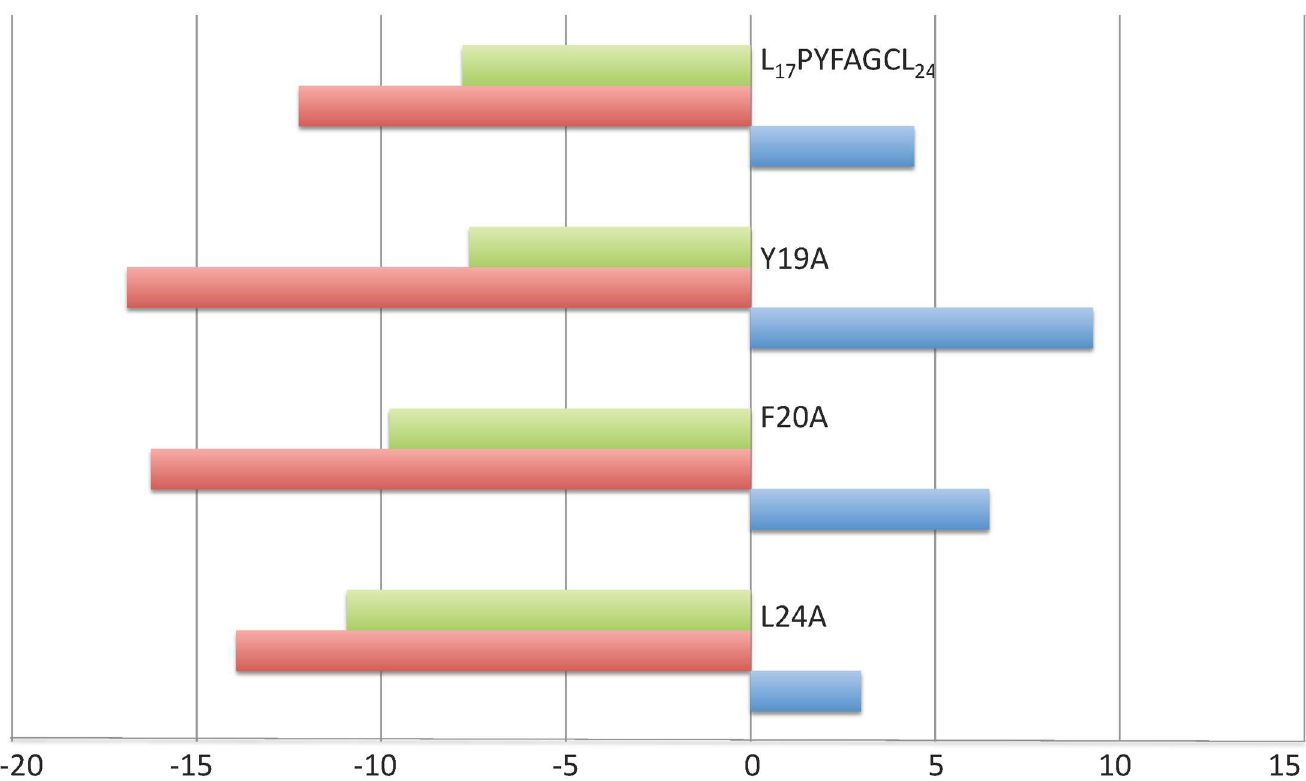
Fig 8. Thermodynamic signatures of the binding on ComR of XIP WT and variants. The enthalpychange ( Δ H), the entropic contribution (-T Δ S) and the Gibbs free energy change ( Δ G) are shown in blue, green and red, respectively,and expressedin kcal mol -1